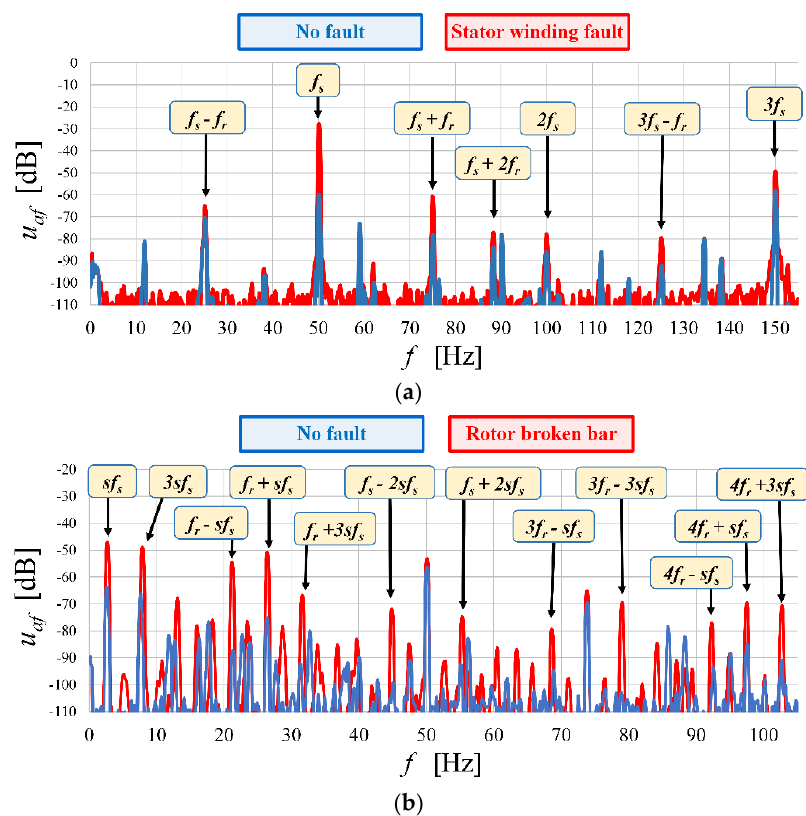
Figure 2. The effect of IM electrical circuit defects on the spectrum of the voltage induced in a measuring coil by an axial flux. Axial flux spectrum: ( a ) for an undamaged motor ( N sh = 0) and with 5 shorted turns in phase A ( N sh = 5), f s = 50Hz, T L =0.2 T LN ; ( b ) for an undamaged motor ( N bb = 0) and with